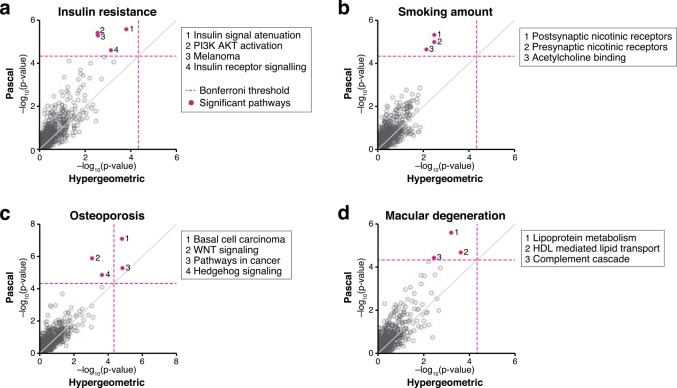
Examples of pathway enrichments comparing Pascal (chi-squared method) to the hypergeometric method.Displayed are results for four phenotypes showing improvement when using Pascal instead of the hypergeometric (binary) enrichment strategy at the 5% threshold level. Underlying gene scores were calculated using the sum method. Dashed lines refer to the Bonferroni significance level when correcting for the number of pathways (1077). Besides from few cancer-related pathways, all pathways highlighted by this analysis have been implied by prior research (see main text). (a) For the trait insulin resistance, Pascal scored the pathway insulin signal attenuation first, followed by two other trait-relevant pathways (PI3K AKT activation and insulin receptor signaling), while the hypergeometric test did not find any significant pathways. (b) For smoking amount (number of cigarettes per day), Pascal revealed three significant pathways related to nicotinic acetylcholine receptors. (c) For osteoporosis, two cancer-related pathways scored significant using both Pascal and the hypergeometric test, but only Pascal revealed the WNT and Hedgehog signaling pathways, which are known to be involved in osteoblast biology. (d) For macular degeneration, Pascal found three significant, trait-relevant pathways related to lipoproteins and the complement system.